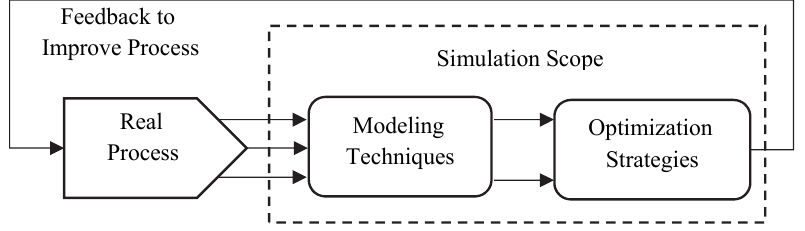
Fig. 4. An overview of simulation scope.